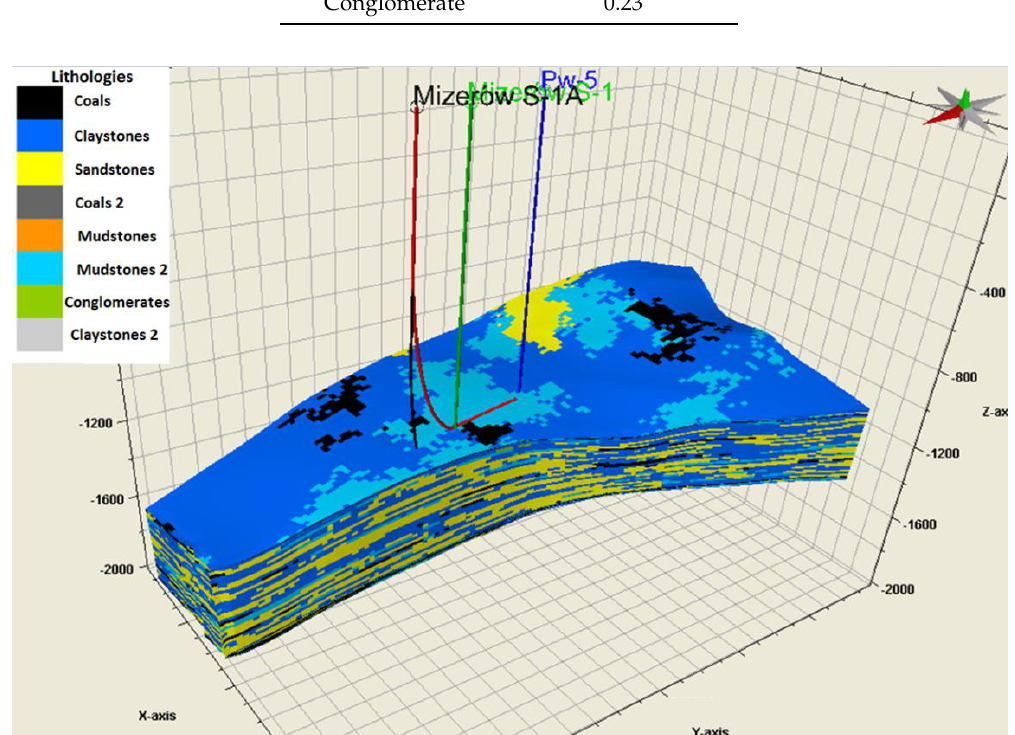
Figure 4. A spatial lithology model of Pawłowice– Mizerów region (USCB, Poland).